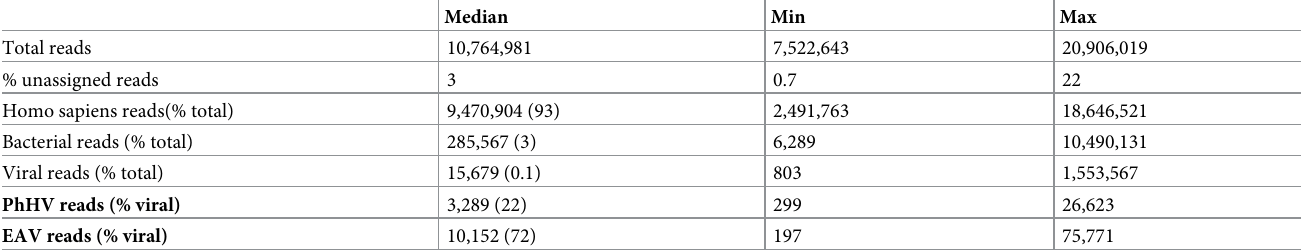
Table 4. mNGS read counts.